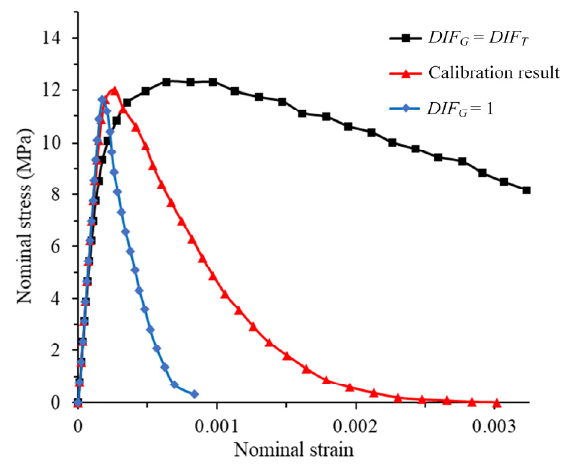
Figure 8. Stress–strain curve for different DIF G .